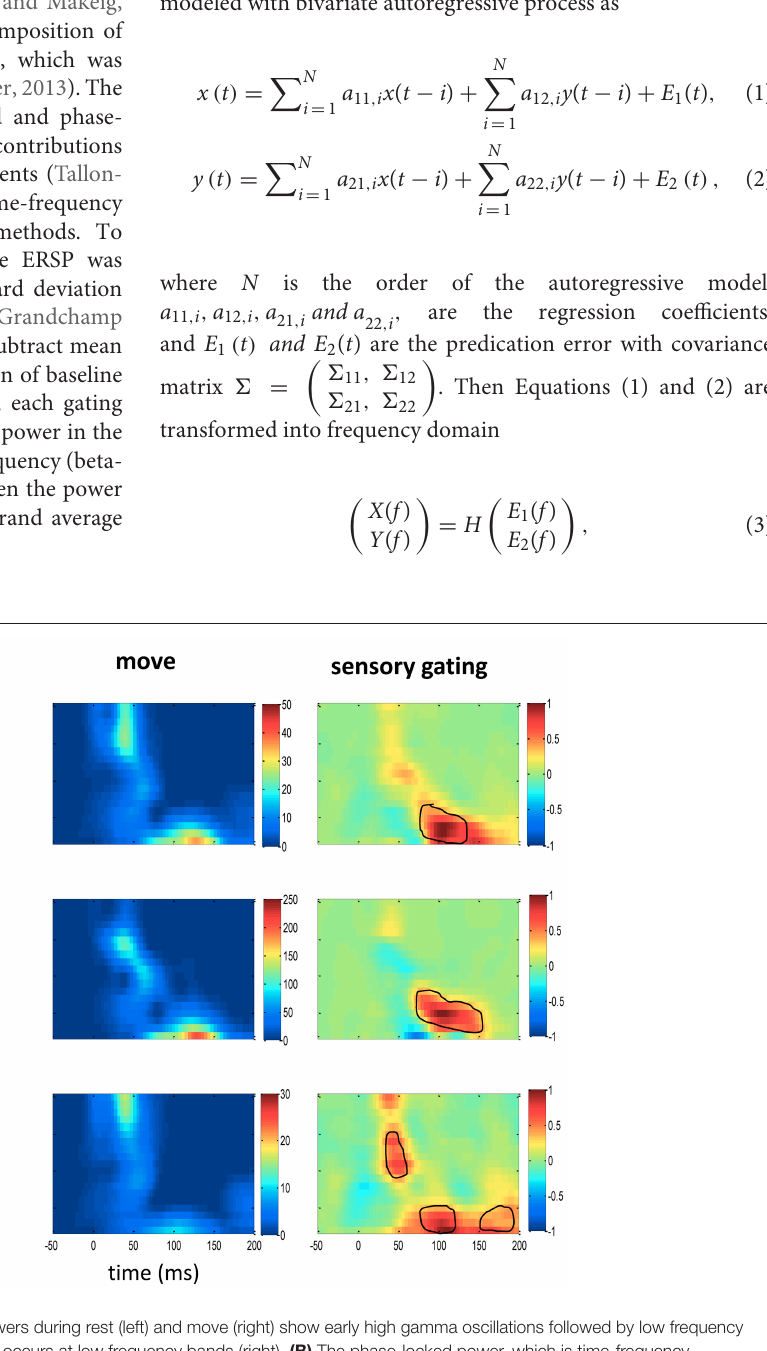
Frontiers in Neural Circuits |